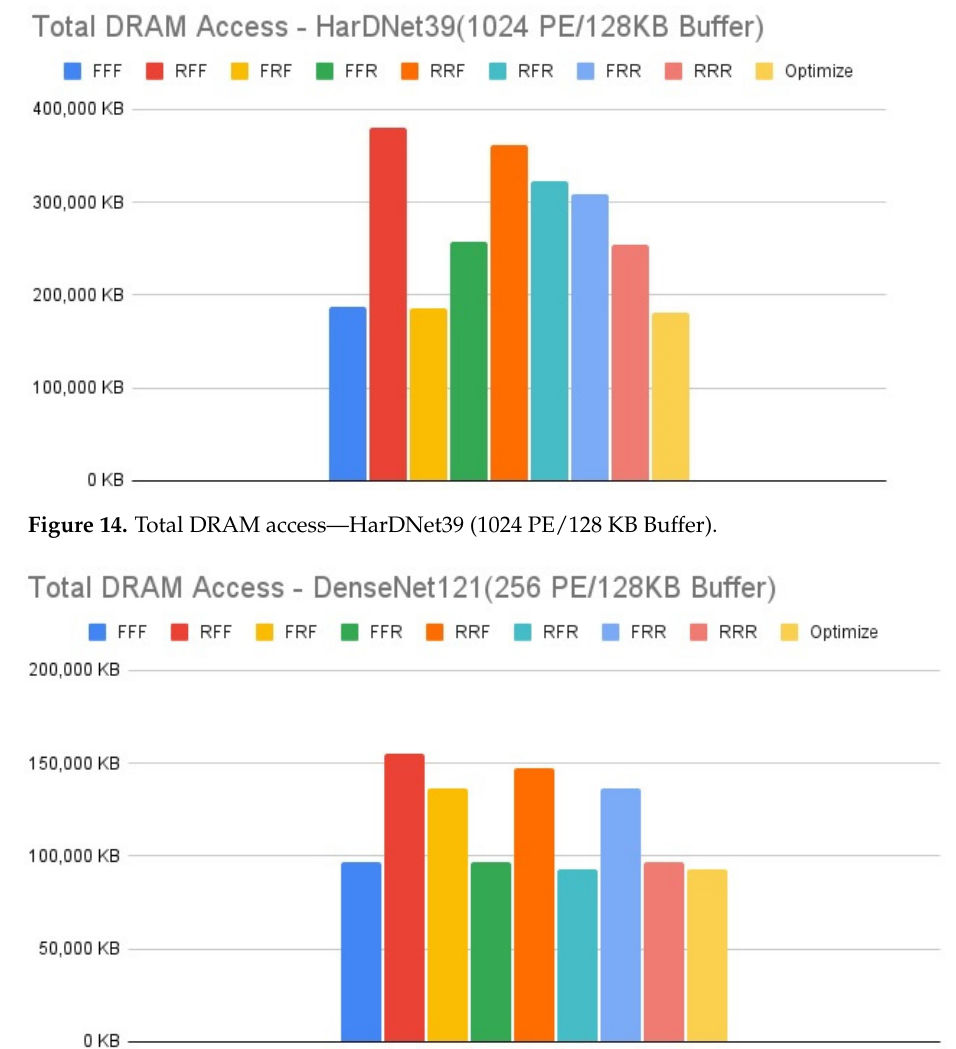
Figure 15. Total DRAM access—DenseNet121 (256 PE/128 KB Buffer).